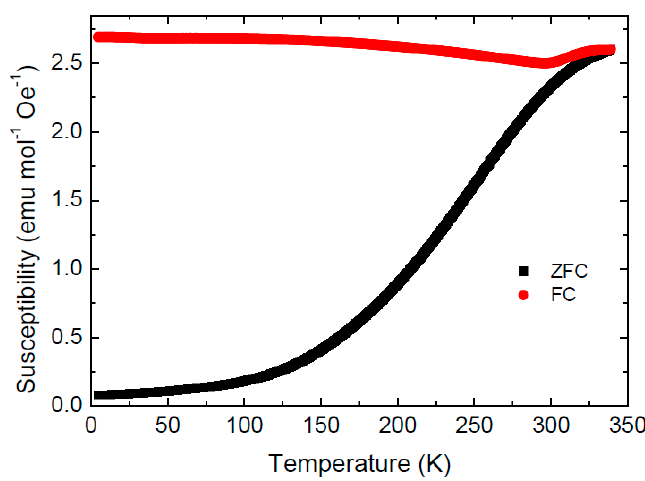
Figure 11. Field cooled (FC) and zero field cooled (ZFC) magnetic susceptibility of Co-Fe-500 sample measured in the temperature sweeping mode at a heating and cooling rate 5 K min − 1 .